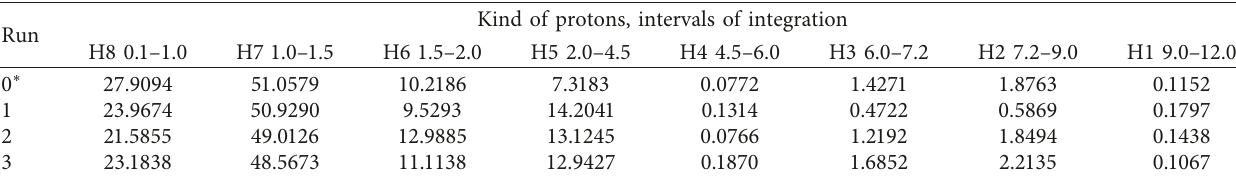
Table 5: Relative percent of protons H1–H8 (SD ± 0.1 − 0.2%).